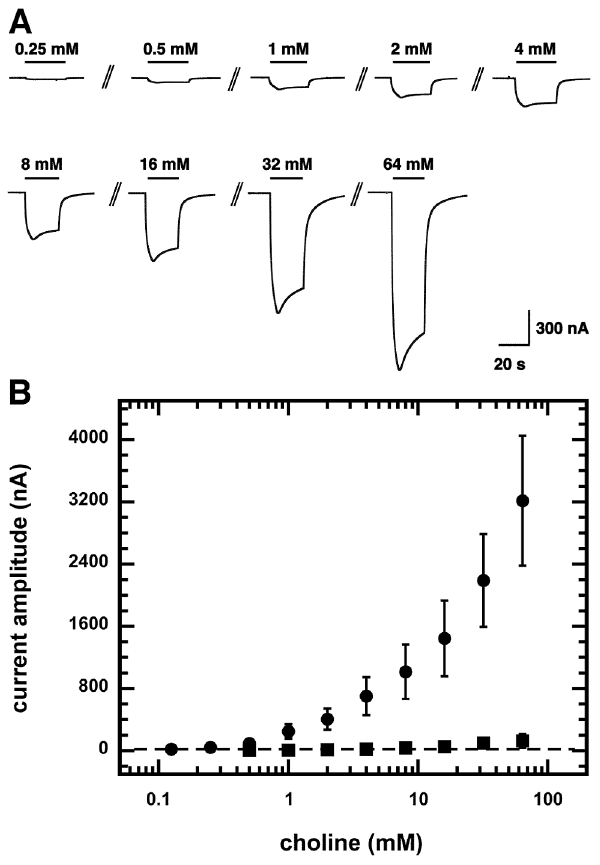
Figure 3. Choline concentration dependence. A) Current traces from a choline concentration response curve obtained from a Xenopus oocyte expressing ACR-23 receptors. The bars indicate the time period of choline perfusion. Choline concentrations are indicated above the bars. B) Current amplitude measured in Xenopus oocytes expressing a wild-type ACR-23 receptor (filled circles) or a mutant ACR-23 receptor (filled squares) after choline perfusion. The mutant ACR-23 subunit corresponding to allele acr-23(cb101) bears a D112N substitution in the extracellular loop. Mean 6 SD of experiments carried out with 4–5 oocytes from two batches are shown.